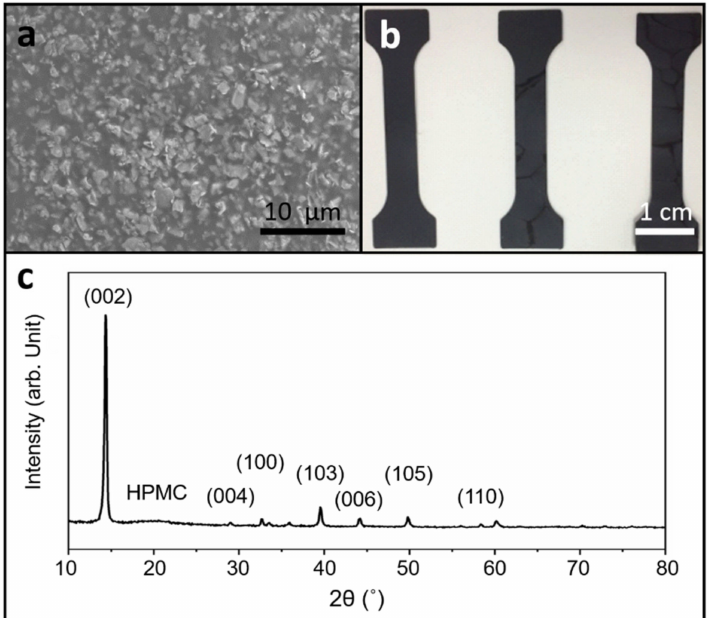
Figure 1. ( a ) SEM image of composite film; ( b ) samples for micro-tensile test; and ( c ) XRD analysis results of MoS 2 /HPMC composite.